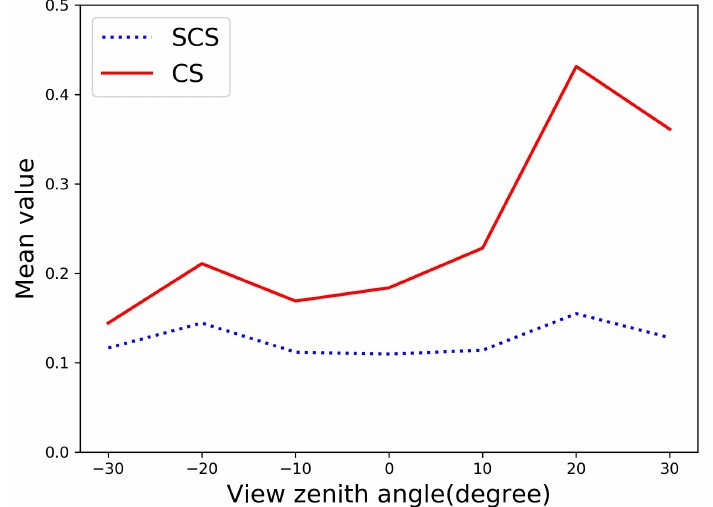
Figure 7. The spatial variation of SCS (blue dotted line) and CS (red line) values with the view zenith angles ranging from − 30 ◦ to 30 ◦ and azimuth angle of 290 ◦ . The x-axis is the view zenith angle and the y-axis are the average of CS and SCS. As compared to CS, the spatial variability of SCS was